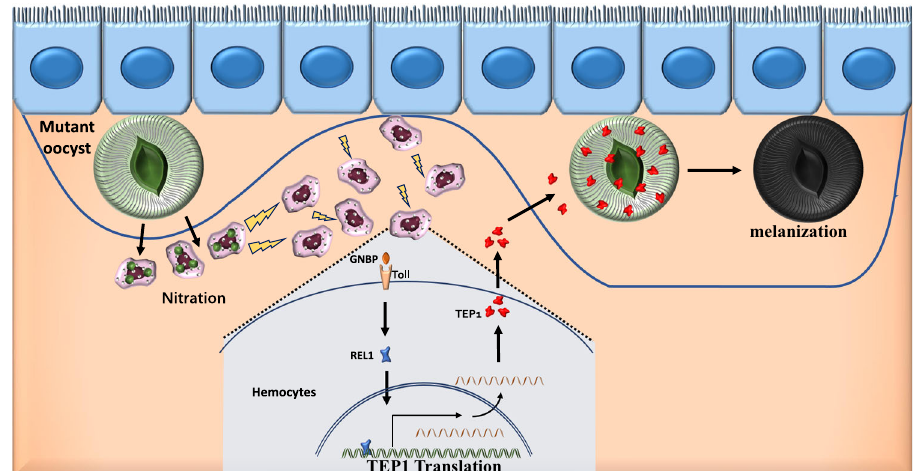
Fig. 7 Schematic illustration showing how CSP mut parasites trigger mosquito immune responses. CSP mut oocysts, with a conformational change in the inner membrane protein CSP due to a mutation in its pexel I/II domain, induce the nitration of hemocytes attached to the midgut and enhance the expression of TEP1 in a Toll pathway-dependent manner. The binding of TEP1 to oocysts results in the melanization or vacuolation of mature oocysts, and the release of sporozoites from the CSP mut oocysts was